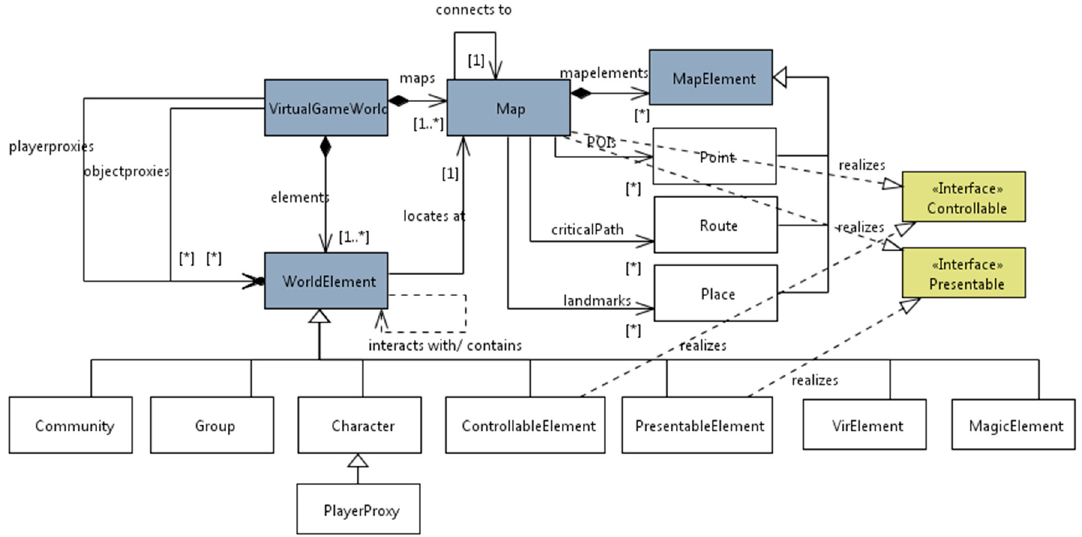
Figure 5. The pervasive game concepts in the virtual game world perspective.